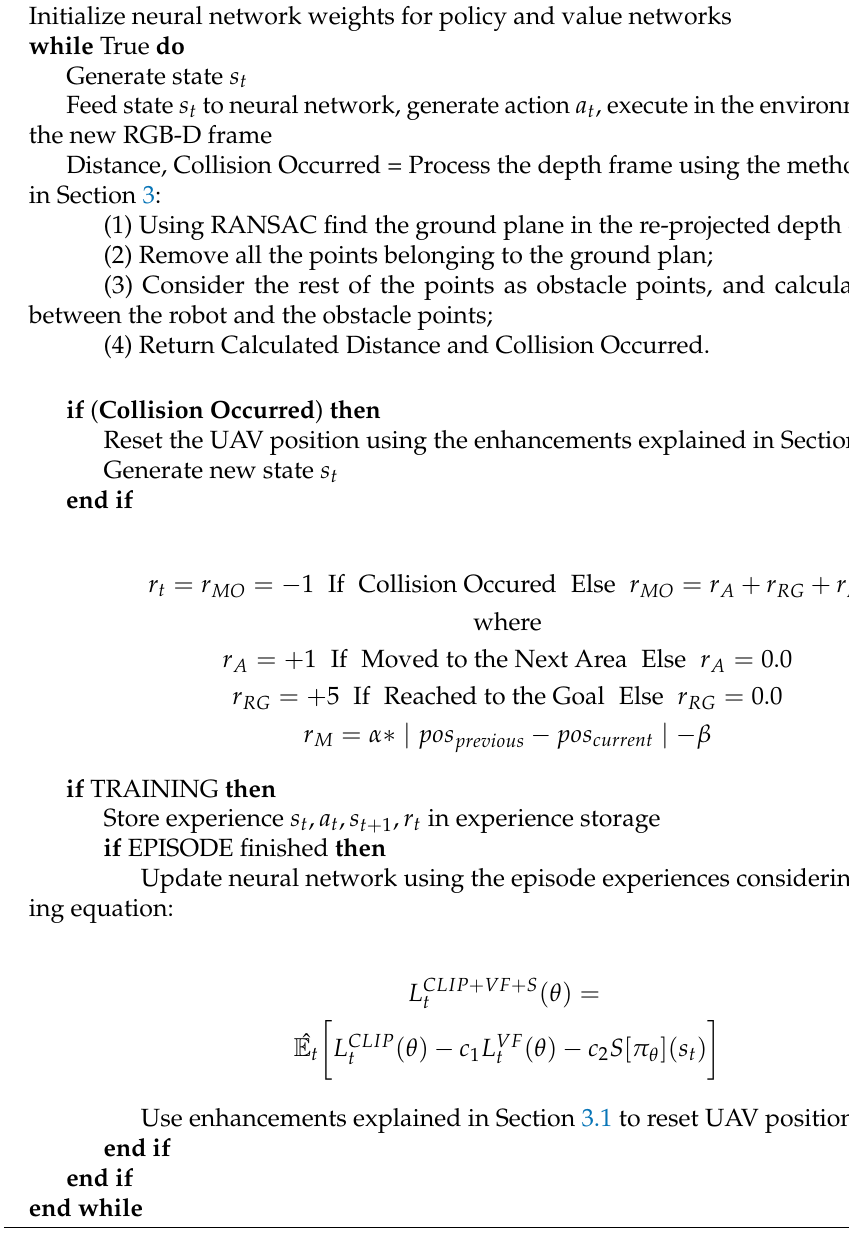
Algorithm 1 Self-trained Controller for Autonomous Navigation (SCAN) Algorithm Initialize neural network weights for policy and value